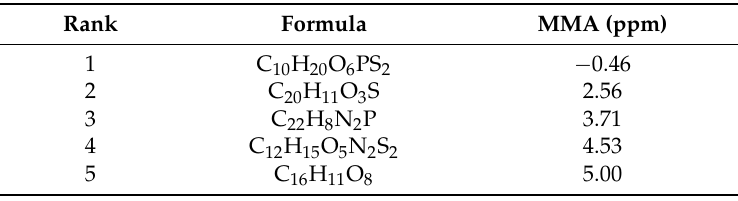
Table 1. Formulae and MMA calculated from accurate masses for the three most intense ions of the DART–MS recording made by FT-ICR, with M / ∆ M of 100,000 FWHM at m/z 400 and using external mass calibration. The search range for formulae was C 0 ´ 25 H 0 ´ 50 O 0 ´ 8 N 0 ´ 2 P 0 ´ 1 S 0 ´ 2 , and the output was limited to even-electron ions. ( a ) Formulae with ď 5 ppm MMA for m/z